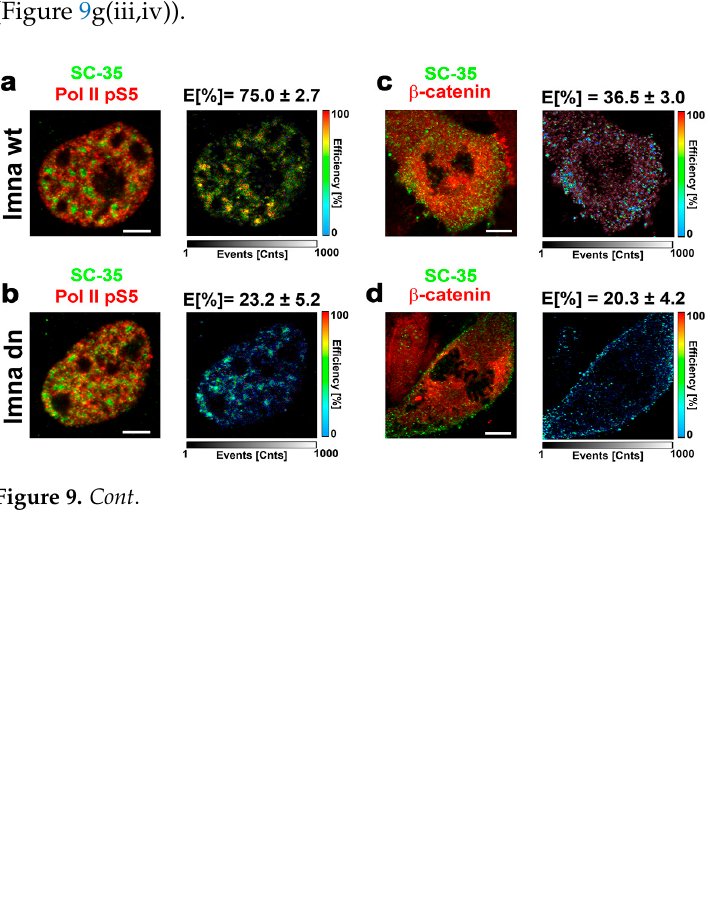
Figure 9. The FLIM–FRET analysis of protein-protein interactions. ( a ) In interphase lmna wt cells, the SC-35 protein interacts with the phosphorylated form of RNAP II (FRET efficiency 75.0% ± 2.7%). ( b ) The depletion of A-type lamins weakened the interaction of SC-35 and RNAP II; FRET efficiency was 23.2 ± 5.2%). ( c ) The SC-35 protein and β -catenin